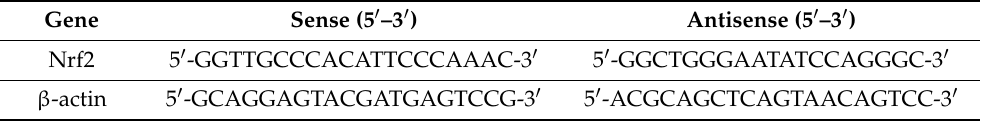
Table 1. Primer sequences of Nrf2 and β -actin